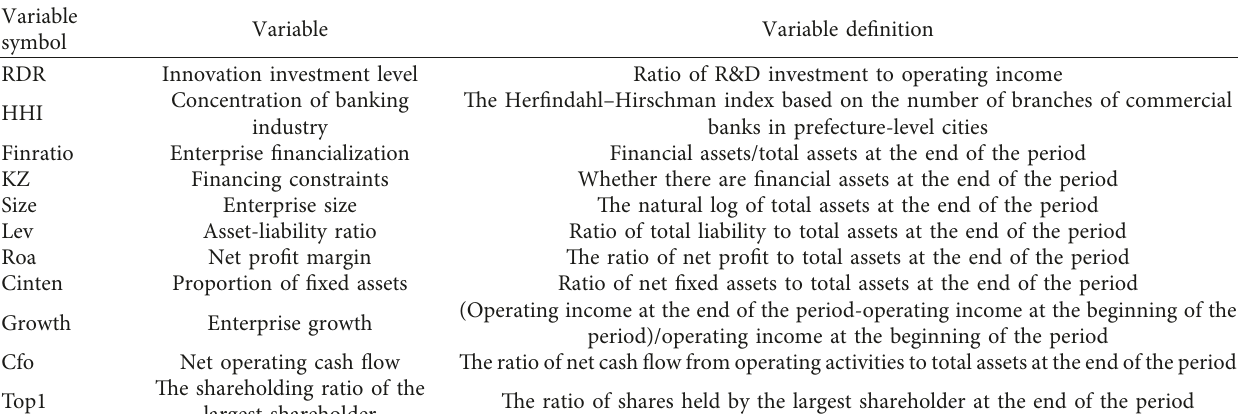
Table 1: Research variable design.